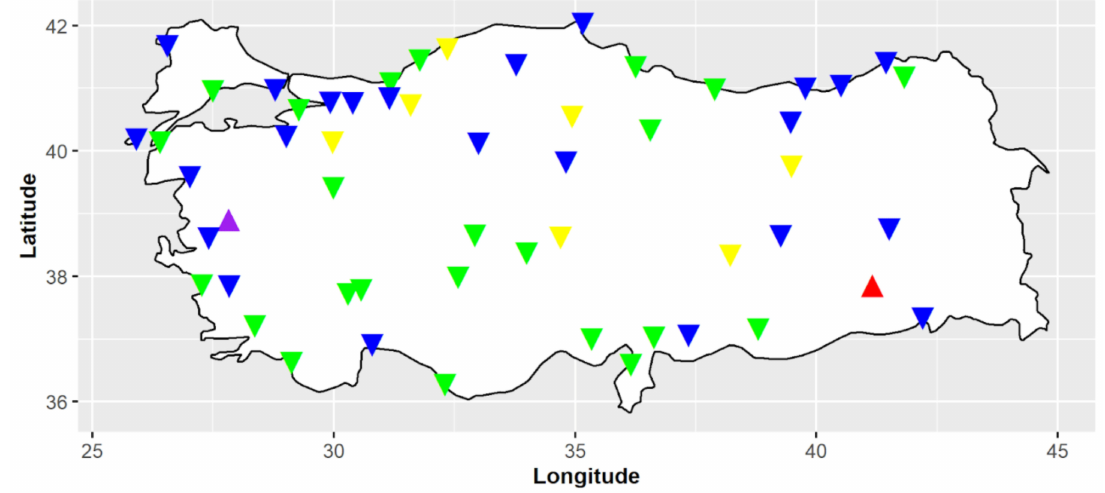
Figure A21. Same as Figure A13 but for August (See Figure A13 for legend).